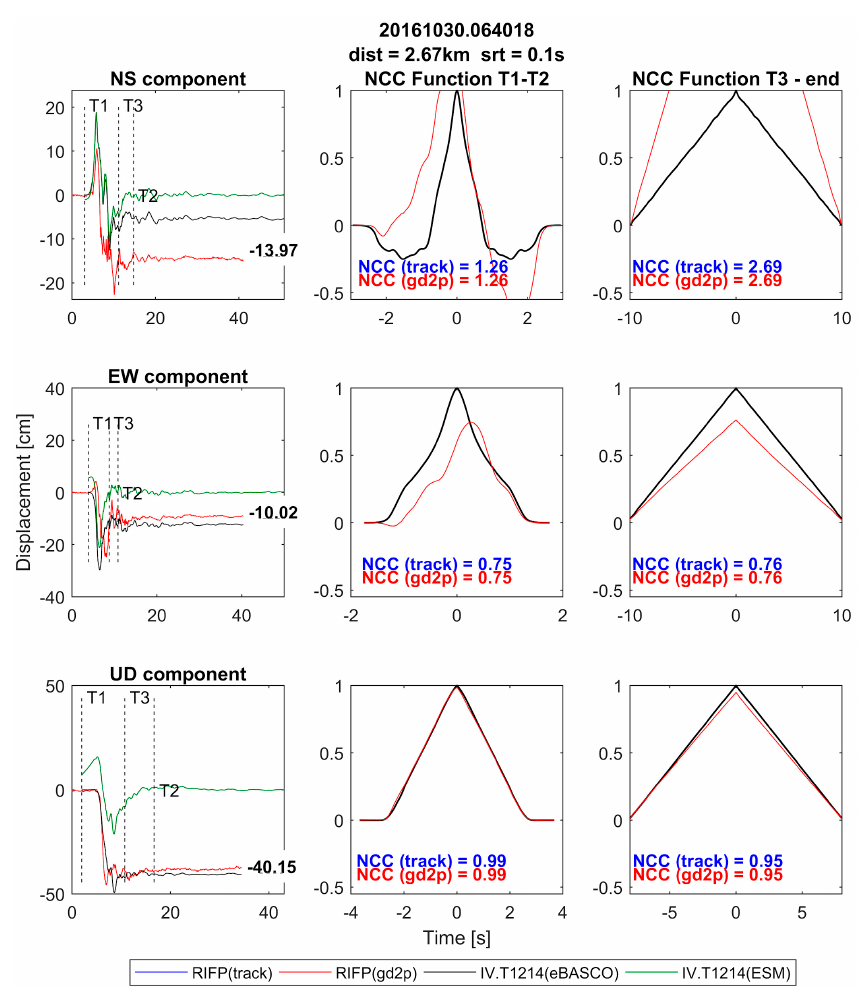
Figure 5. Comparison between displacement time series (two horizontal and vertical component) obtained by eBASCO method (black line) and from Engineering Strong Motion (ESM) database (green line) recorded at IV.T1214 station during the Mw6.5 Norcia earthquake and HRGPS time series from the co-located RIFP station. The coseismic displacement measured by HRGPS is also reported in the 1st column of each plot together with the correction points (T 1 , T 2 and T 3 ). Normalized autocorrelation function (ACC) (black line) and normalized cross-correlation (NCC) function between HRGPS and eBASCO displacement (red line) are shown in the 2nd and 3rd columns. ACC and NCC were calculated between T 1 and T 2 (2nd column) and between T 3 and the end of signal (3th column); dist: interdistance between strong-motion and GPS station; srt: sampling rate of the HRGPS records; gd2p and track: different processing scheme of the HRGPS data (http://gipsy.jpl.nasa.gov (accessed on 29 December 2020), [27]; http://www.gpsg.mit.edu/~simon/gtgk/ (accessed on 29 December 2020),